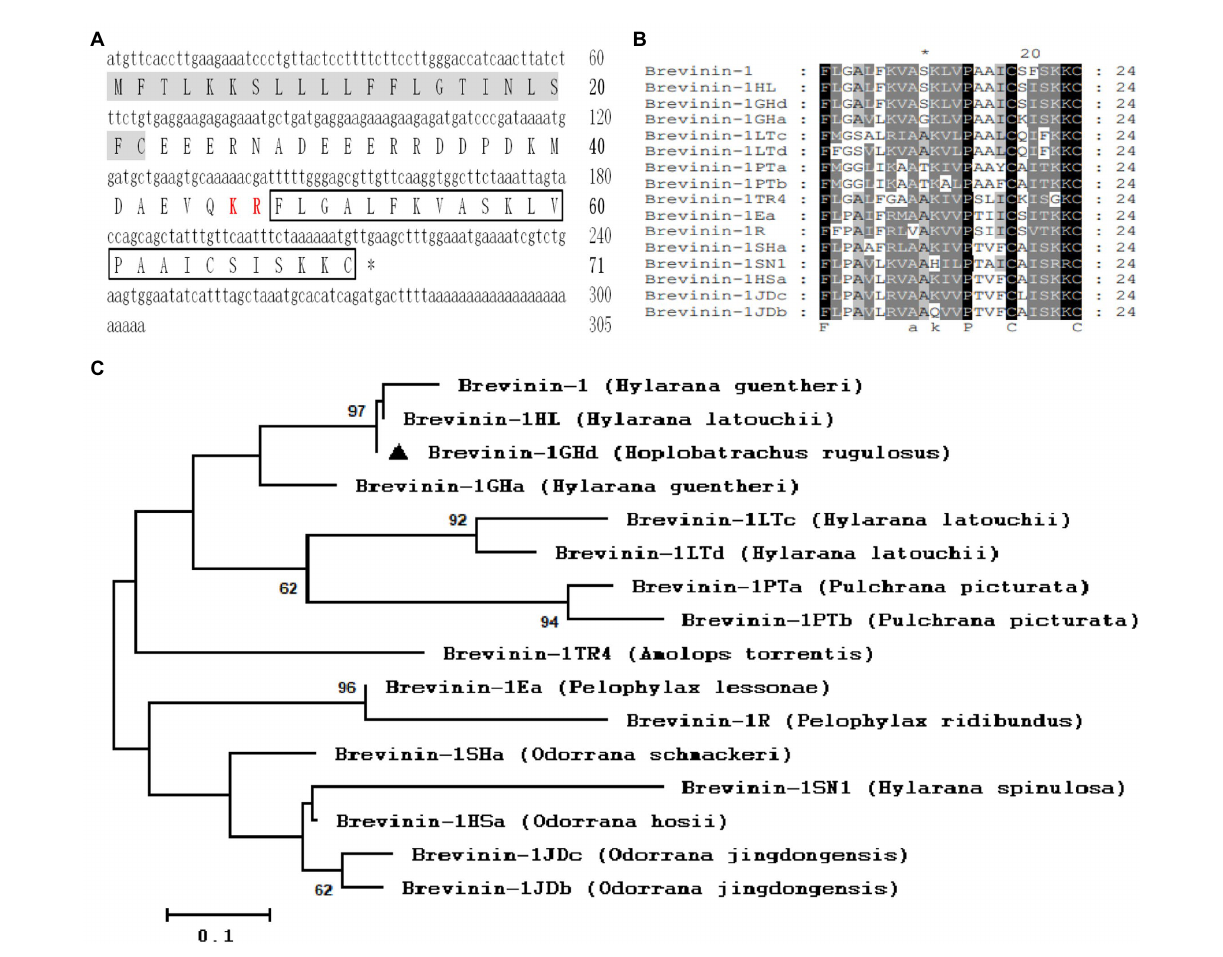
FIGURE 1 Sequence Analysis of Brevinin-1GHd. (A) The cDNA and predicted amino acid sequences of Brevinin-1GHd. The signal peptide and KR protease cleavage site are labeled with a gray background and red style, respectively. The amino acid sequence of mature Brevinin-1GHd is boxed, and the stop codon is indicated by an asterisk (*). (B) Amino acid sequence alignment of mature Brevinin-1GHd with other Brevinins-1 peptides from different frogs. The identical residues are marked with a black background. (C) Phylogenetic analysis of Brevinins-1 from different frogs. Numbers at the forks symbol the percentage of trees in which this group occurs after bootstrapping (1,000 replicates; shown only when >60%). Scale bar shows the number of substitutions per base. Replicates are applied to prove the reliability of each